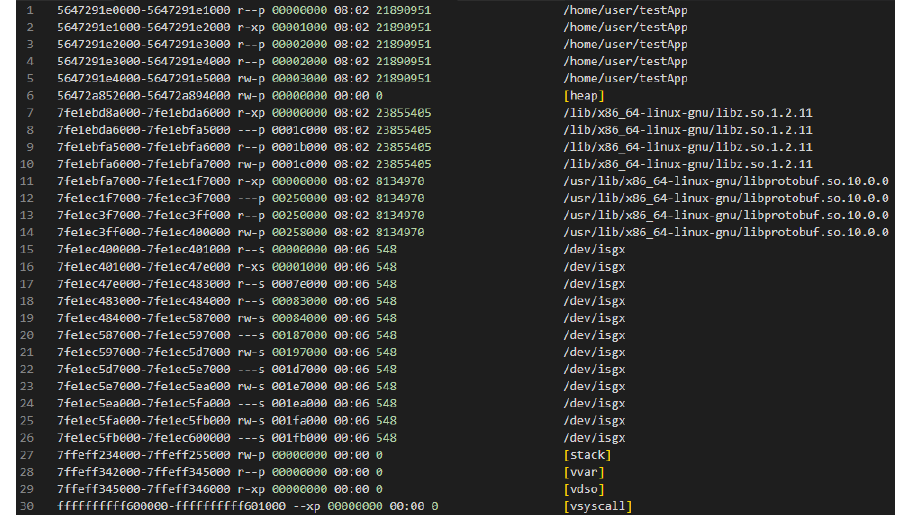
Figure 3. Contents of /proc/pid/maps